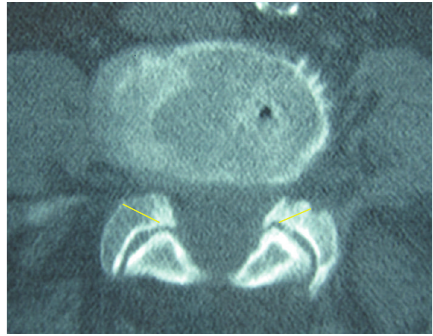
Figure 6: Axial CT scan image demonstrating foraminal stenosis and the planned bone resection.